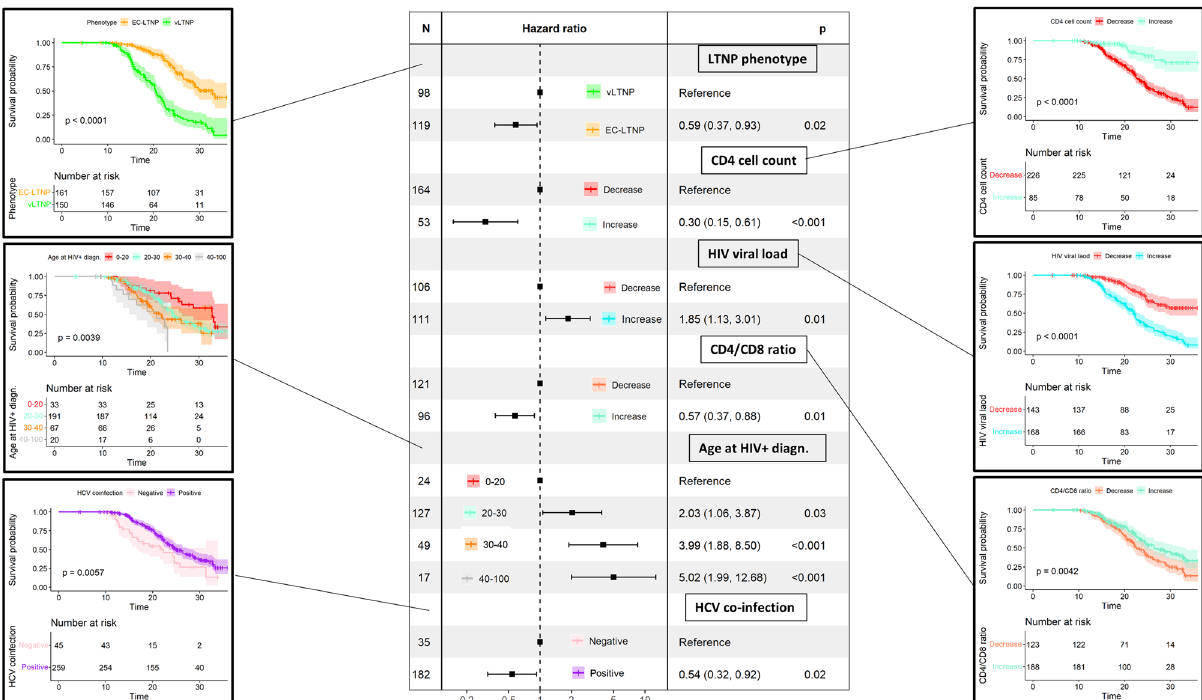
Figure 5. Probability of retaining LTNP phenotype in LTNP-RIS cohort participants and hazard ratios of significant variables. Kaplan–Meier estimates of the probability of retaining LTNP phenotype of the statistically significant covariates in univariate analyses (LTNP phenotype, age at HIV + diagnosis, HCV coinfection and variations in CD4 cell count, HIV VL and CD4/CD8 ratio). Determinants associated with loss of LTNP phenotype in a multivariate Cox proportional hazards model are showed in the middle. Time is expressed in years from HIV + Disease progression. Participants primarily classified as EC-LTNP suppose 52.1% of LTNP-RIS, includ- ing a 60.0% of all women and a 47.8% of all men, and those individuals primarily classified as vLTNP constitute 47.9% of LTNP-RIS, including 40.0% of all women and 52.2% of all men. Some of these participants primarily classified as LTNP lost their status due to different causes, including the initiation of ART, a decrease in CD4 T cell count to below 500 cells per μl (immunologic progression), and/or an increase in HIV VL above 10,000 cop- ies/mL (virologic progression). LTNP-RIS cohort includes 53 EC-LTNP (32.5% of all EC-LTNP) and 98 vLTNP (65.3% of all vLTNP) which lose LTNP phenotype ( p = 1.3 × 10 −7 ). In the case of ExLTNP initially classified as EC-LTNP, a median CD4 count of 468 cells/μl (IQR = 367–608 cells/μl) and a median viral load of 246 copies/ mL (IQR = 64–2134 copies/mL) were detected just before the initiation of ART. On his part, vLTNP becoming ExLTNP showed a median CD4 count of 410 cells/μl (IQR = 285–578 cells/μl) and a median viral load of 8518 copies/mL (IQR = 1075–25,553 copies/mL) before the initiation of ART. Only 13 EC-LTNP were reclassified as vLTNP during follow-up (8.0% of all EC-LTNP) because of an increase in HIV VL. A total of 29 AIDS-defining opportunistic infections were detected in 24 cohort participants, including pul- monary tuberculosis (n = 11), progressive multifocal leukoencephalopathy caused by JC papovavirus infection (n = 4), esophageal candidiasis (n = 3), bacterial recurrent pneumonia (n = 3), Pneumocystis jirovecii pneumonia (n = 2), Kaposi´s sarcoma caused by HHV-8 infection (n = 2), HIV encephalopathy (n = 2), and HPV cervical cancer (n = 2). Although the frequency in EC-LTNP who maintain the phenotype during follow-up was the lower found in the cohort, the differences with vLTNP (4.1% versus 9.6%, p = 0.28) and with those losing LTNP condition were not statistically significant (4.1% versus 9.4%, p = 0.28). There was also no difference comparing the vLTNP who maintain the phenotype with those that lose it (9.6% versus 10.2%, p = 1.0). Differences in the progression-free survival curves of EC-LTNP and vLTNP were identified ( p < 2.2 × 10 −16 ). The estimated progression-free probabilities were 100% for EC-LTNP and vLTNP at 10 years, 88.4% (95% CI 83.1–93.9%) for EC-LTNP and 57.2% (95% CI 49.2–66.6%) for vLTNP at 20 years and 50.5% (95% CI 40.9–62.3%) for EC-LTNP and 17.9% (95% CI 11.5–27.8%) for vLTNP at 30 years. Regarding the different phenotypes of loss of LTNP status, the estimated progression-free probabilities at 20 years were 80.9% (95% CI 65.8–99.6%) for EC-LTNP primarily re-classified as vLTNP and then losing LTNP status, 61.3% (95% CI 46.3–81.1%) for EC-LTNP losing LTNP status directly, and 43.9% (95% CI 35.1–54.9%) for vLTNP who lost LTNP status. These differences in the estimated progression-free probabilities between groups of individuals aug- mented at 30 years, reaching 9.5% (95% CI 2.6–35.6%), 3.2% (95% CI 0.5–22.2%), and 5.1% (95% CI 2.2–12.0%) for EC-LTNP primarily reclassified as vLTNP and then losing LTNP status, EC-LTNP losing LTNP phenotype directly, and vLTNP losing LTNP phenotype, respectively (Fig. 5).